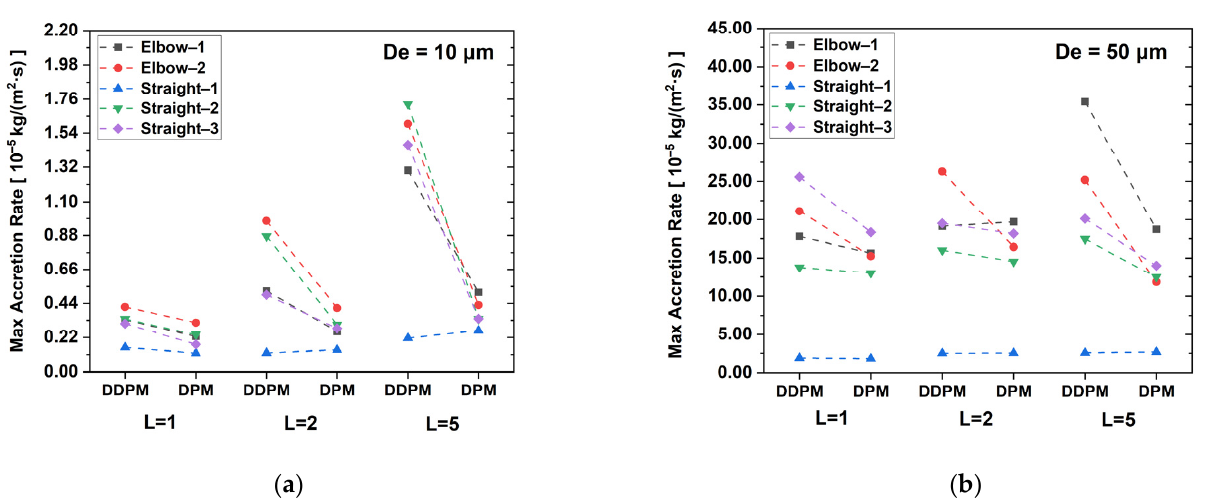
Figure 12. Comparison of the maximum accretion rate calculated by the DDPM and the DPM: ( a ) The average particle size is 10 μ m; ( b ) The average particle size is 50 μ m. Table 4. The relations between the mass flow rate of particle flow and average particle